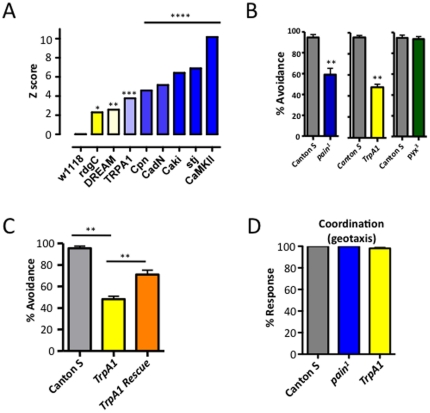
TrpA1 is a novel Drosophila nociception gene.(A) Thermal avoidance of a select list of elav-Gal4×UAS-IR lines targeting genes involved in Ca2+ signaling are depicted with Z-score and calculated significance. (B) TrpA1 and painless (pain1), but not pyrexia (pyx3) mutant flies exhibit defects in thermal nociception in adult Drosophila. (C) Re-introduction of TrpA1 on the TrpA1 mutant background is sufficient to rescue the defective adult thermal nociception response, establishing that the observed thermal nociception defect is specific to TrpA1 expression and not the result of secondary effects. (D) Loss of painless or TRPA1 does not affect basic motor coordination as assayed by a negative geotactic assay. Data are presented as mean values +/− SEM. ∼20 flies tested per group, in replicates of at least four cohorts. In all experiments ∼20 flies were tested per group in replicates of at least four. In all experiments adult flies were challenged with 46°C as outlined in Figure 1D. * P<0.05, ** P<0.01, *** P<0.001, **** P<0.0005 (based on (A) Z score and (B–C) Students t-test).